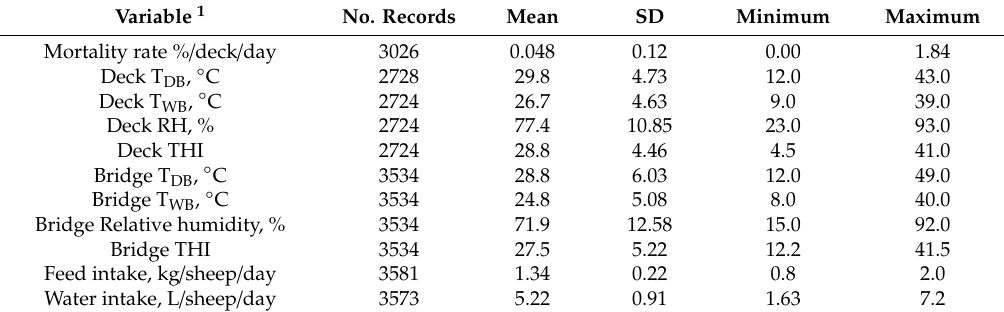
Table 3. Descriptive statistics for sheep mortality rate (% / deck / day), environmental measurements and feed and water intake from fourteen voyages from Australia to the Middle